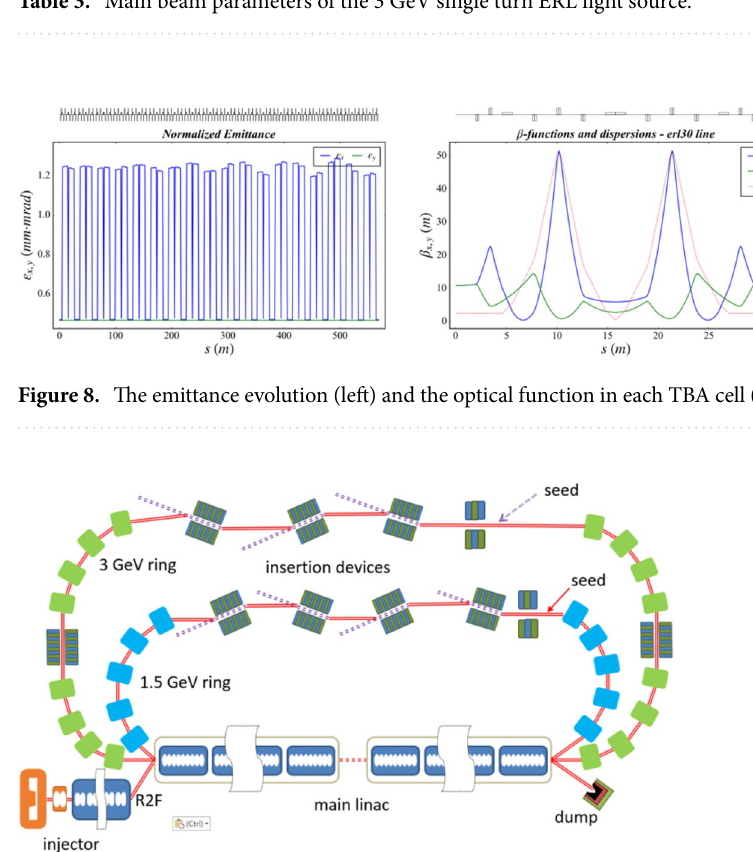
Table 3. Main beam parameters of the 3 GeV single turn ERL light source.